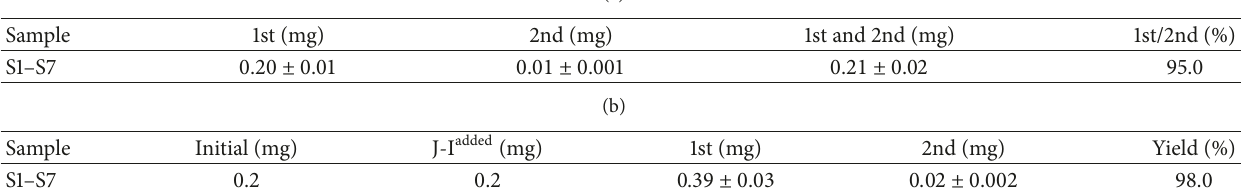
Figure 4: Proton and carbon NMR spectra for javamide-II. (a) Proton NMR spectrum and (b) carbon NMR spectrum. The proton and carbon numbers were depicted with chemical shifts in parenthesis. Table 1: (a) The amounts of javamide-I in 1st and 2nd extractions. The mixture of seven green coffee extract samples ((1) Nature Made Inc., (2) BioRise Nutrition, (3) GMX Naturals, (4) Natrogix, (5) Pro Nutrient Labs, (6) The Health Life, and (7) Wellsome Nutrition) was extracted twice with 70% MeOH (50 mL), providing the 1st and 2nd extracts. The amounts of javamide-I were presented as mg per 1g green coffee sample ( 𝑛 = 5 ). (b) The recovery yield of javamide-I. The purified javamide-I (0.2 mg) was added to the mixture of the seven green coffee extract samples containing 0.2 mg javamide-I and extracted with 70% MeOH. The recovery was determined using 1st and 2nd extracts ( 𝑛 = 5 ).